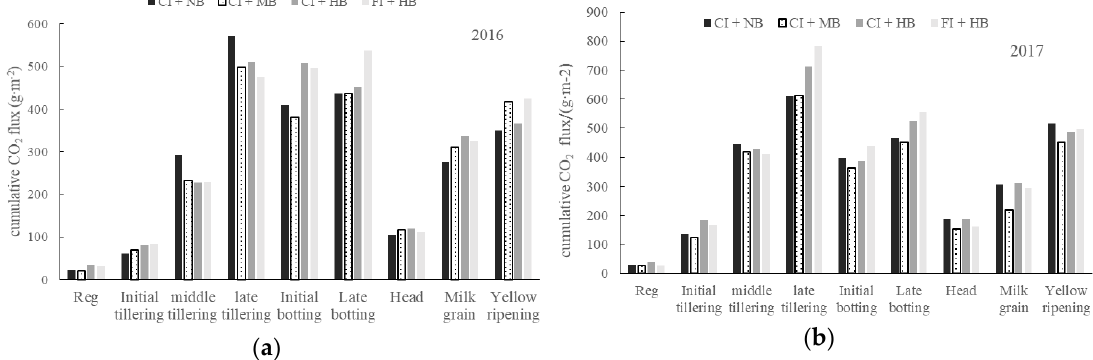
Figure 3. CO 2 emission fluxes at different growth stages of rice under different amounts of biochar application in 2016 ( a ) and 2017 ( b ) (Reg denotes re-greening stage and Head denotes heading and flowering stage).